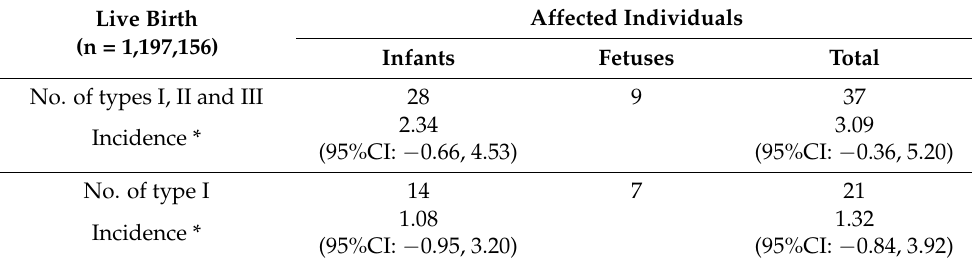
Table 3. Incidence of SMA in Osaka and Hyogo